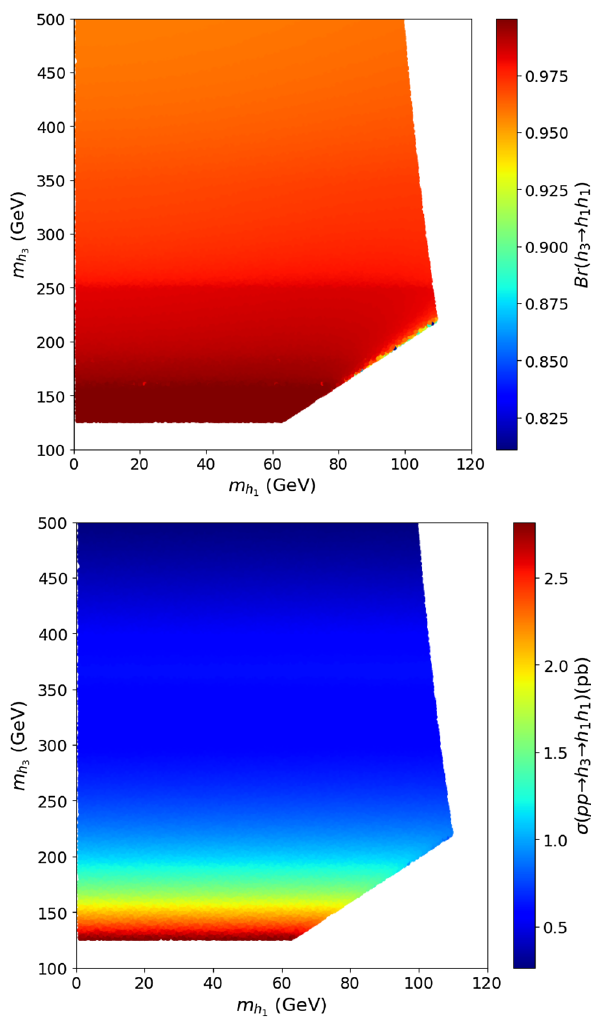
Fig. 7 The mass spectra of the h 1 , 3 Higgs bosons for BP2. The color code shows BR ( h 3 → h 1 h 1 ) (upper panel) and the σ( pp → h 3 → h 1 h 1 ) (lower panel). We set (cid:15) = 7